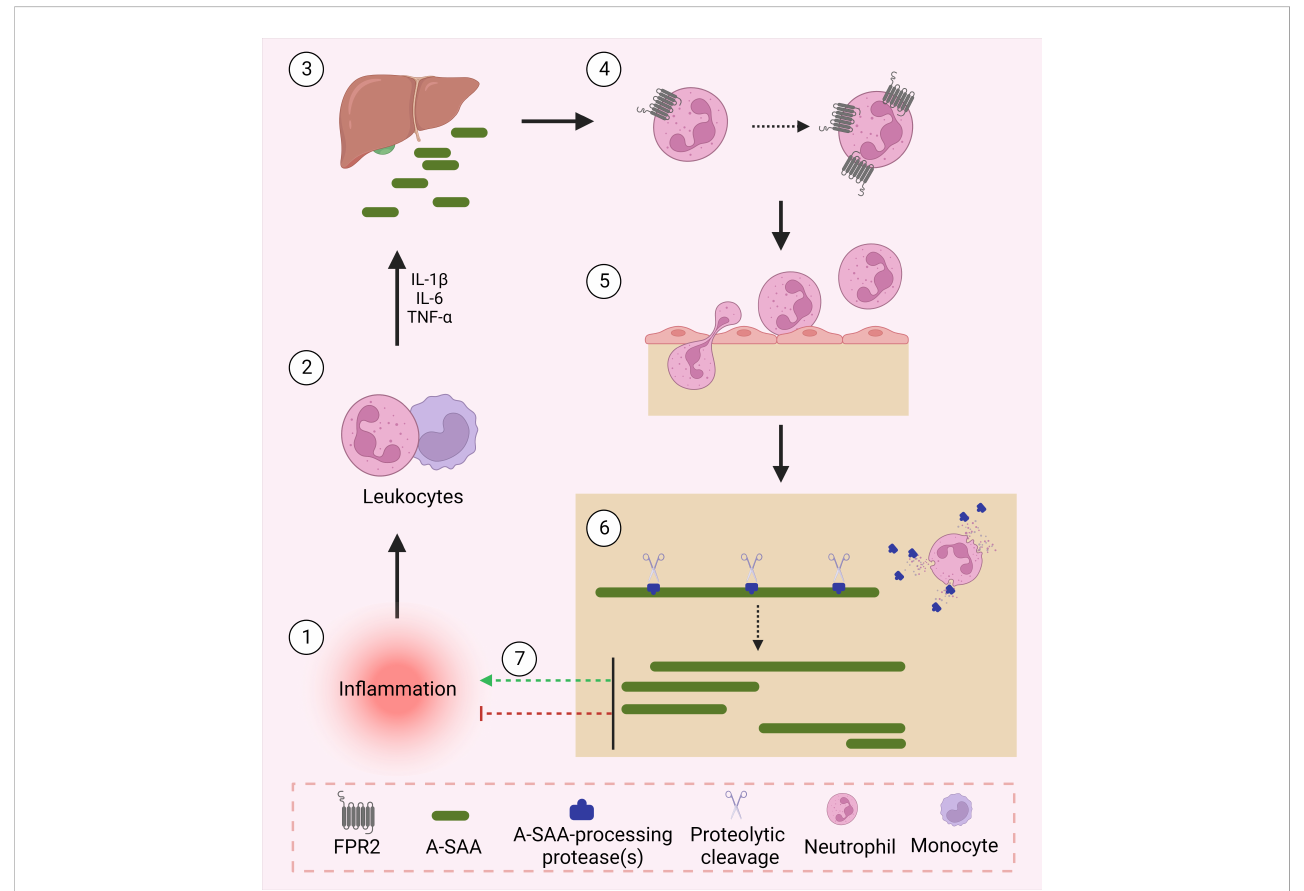
FIGURE 1 A-SAA and its derived peptides regulate in fl ammation. Following an in fl ammatory stimulus, leukocytes activate the acute phase response through their expression of cytokines namely, IL-1 b , IL-6 and TNF- a . In turn, upregulated cytokines activate the liver to express acute phase proteins including A-SAA. A-SAA acts on neutrophils to upregulate their expression of the plasma membrane receptor FPR2. Through its activation of FPR2, A-SAA enhances the migration of neutrophils into the site of in fl ammation. At the site of injury, recruited neutrophils release proteases that cleave A-SAA at different sites thereby generating distinct A-SAA-derived peptides which either further enhance the in fl ammatory response or rather relay a pro-resolving